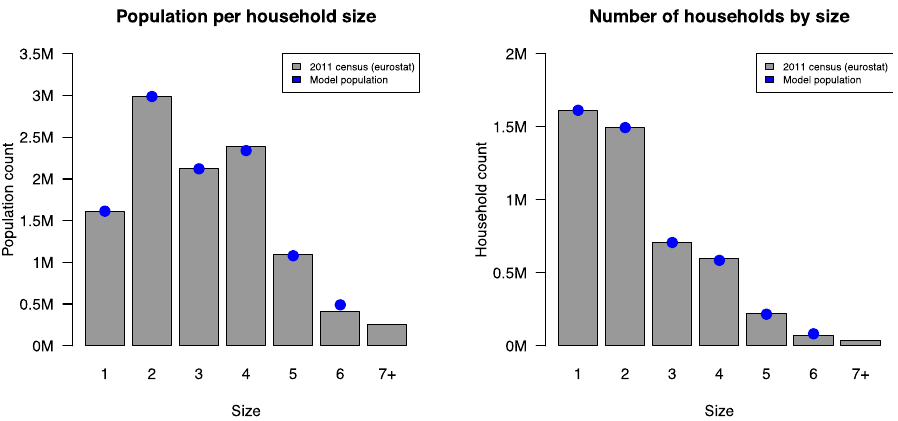
Fig 8. Population size per household size and number of households per size: Belgian 2011 census and model population. Numbers are expressed in million (M). Figure from Willem et al. [21].